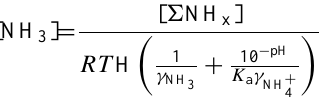
20.10 The diffusion coefficient in free Li and Gregory (1974)